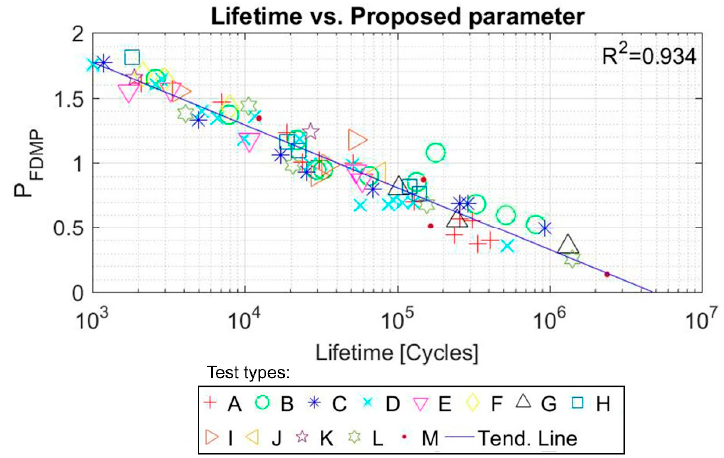
Figure 12. Proposed FDMP and tests lifetime (cycles) correlation for NBR tests. Initial data from [45].